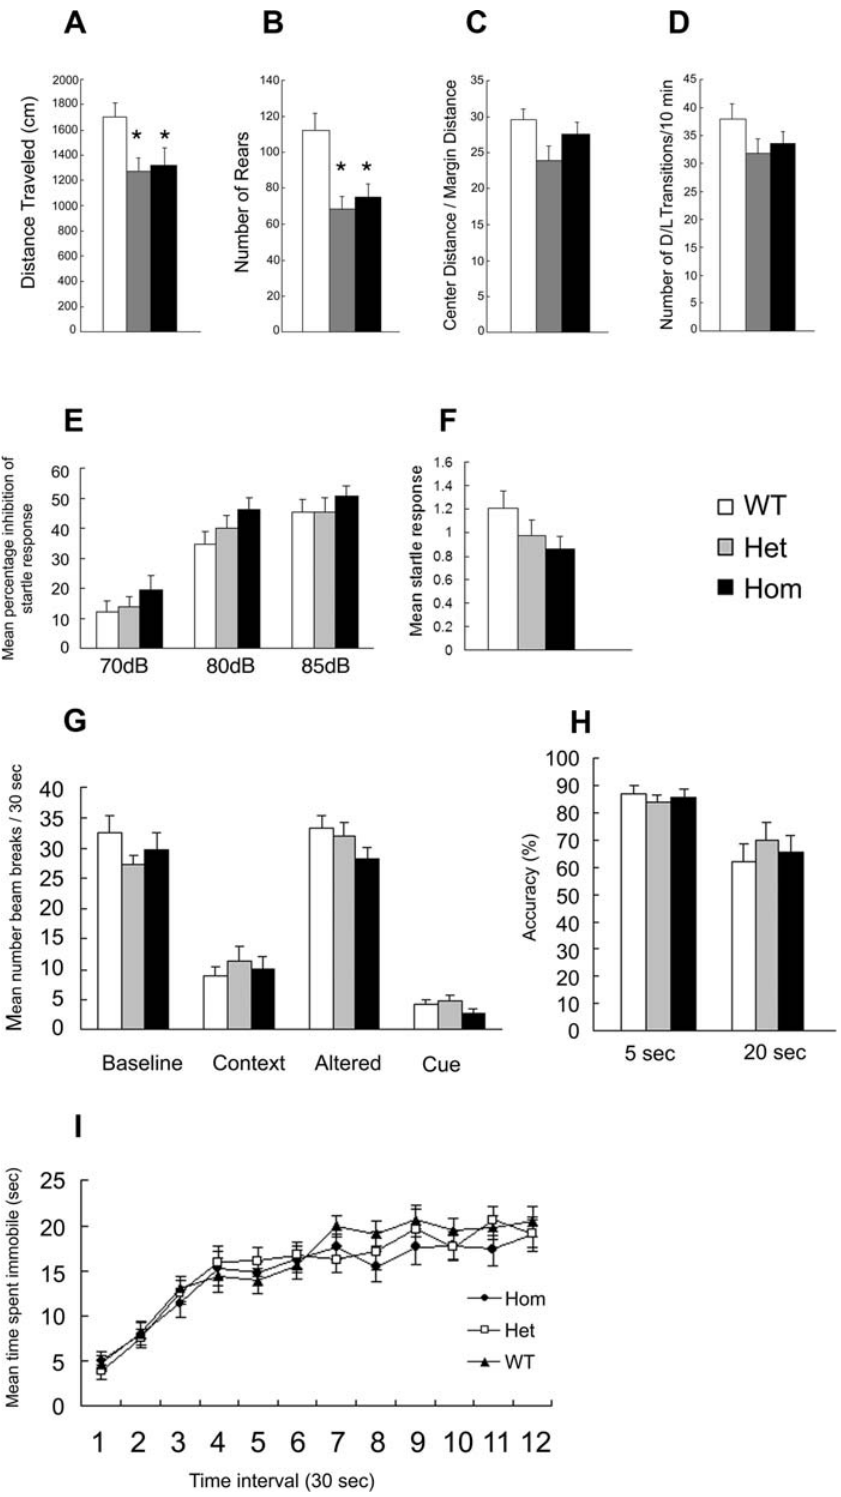
Figure 3. Behavioral characterization of Rtn4r-deficient mice. (A) Total distance traveled, (B) mean number of rears, and (C) ratio of center traveled distance/margin traveled distance in a 20-min open field test. (D) Number of dark-to-light transitions in a 10-min dark/light transition test. (E) PPI using combinations of one startle level (120 dB) and three prepulse levels (70, 80 and 85 dB). (F) Startle response at 120 dB. (G) Contextual and cued fear-conditioning paradigm. Activity (beam breaks) was measured at baseline, after reintroduction into the same context where training occurred (context), at baseline in an altered context (altered), and after presentation of the cued conditioned stimulus in the altered environment (cue). (H) Accuracy in a working memory test after a 5-sec or 20-sec inter-trial delay using a delayed alternation T-maze assay. (I) Mean time spent immobile in a tail suspension test. All results shown are from combined sexes. All data are represented as mean 6 S.E.M.